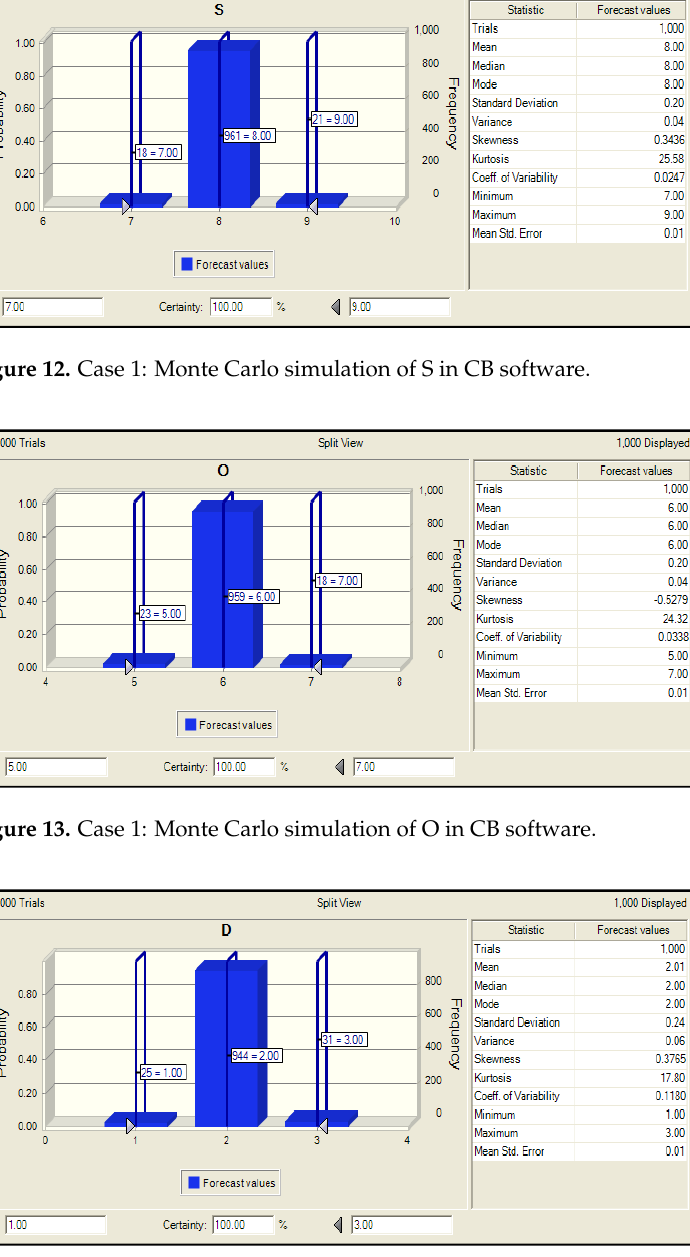
Figure 14. Case 1: Monte Carlo simulation of D in CB software.